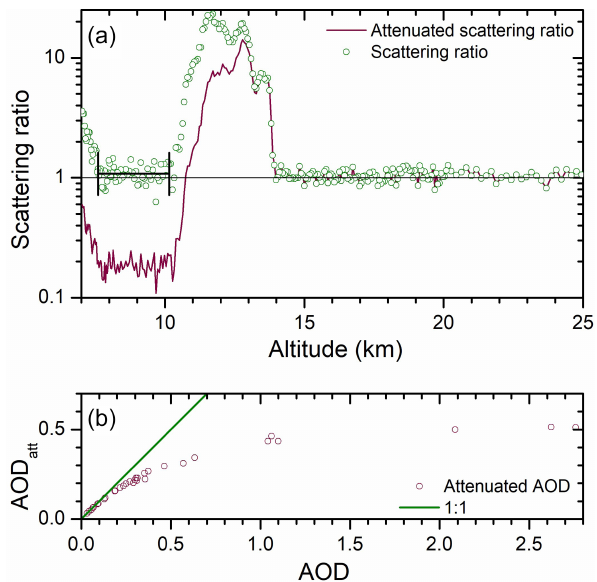
Figure 3. Illustration of the attenuation correction methodology and its effect. (a) The attenuated and corrected scattering ratios as a function of altitude. Example of a methodology for one smoke layer, where the scattering ratio between 7.5–10km altitude, below the smoke layer at 10.5–14km, is targeted to a value of 1.08 (explained in the Sect. 2.1.2) by iteratively fitting the lidar ratio for 532nm wavelength. (b) The attenuated layer AOD (AOD att ) related to the layer AOD corrected for attenuation. The 1 : 1 relation is shown by the full